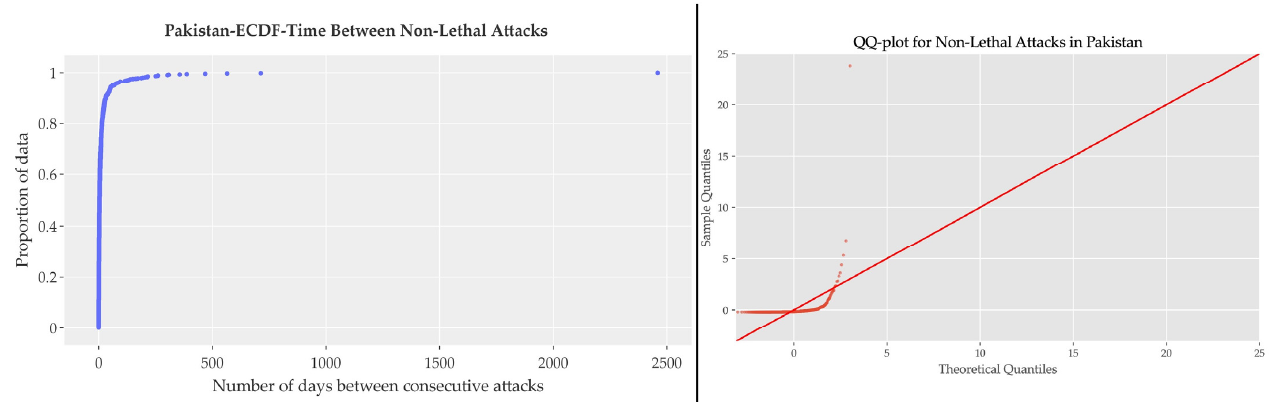
Figure 9. The time between consecutive non-lethal a tt acks and the corresponding QQ plot for Paki- stan.